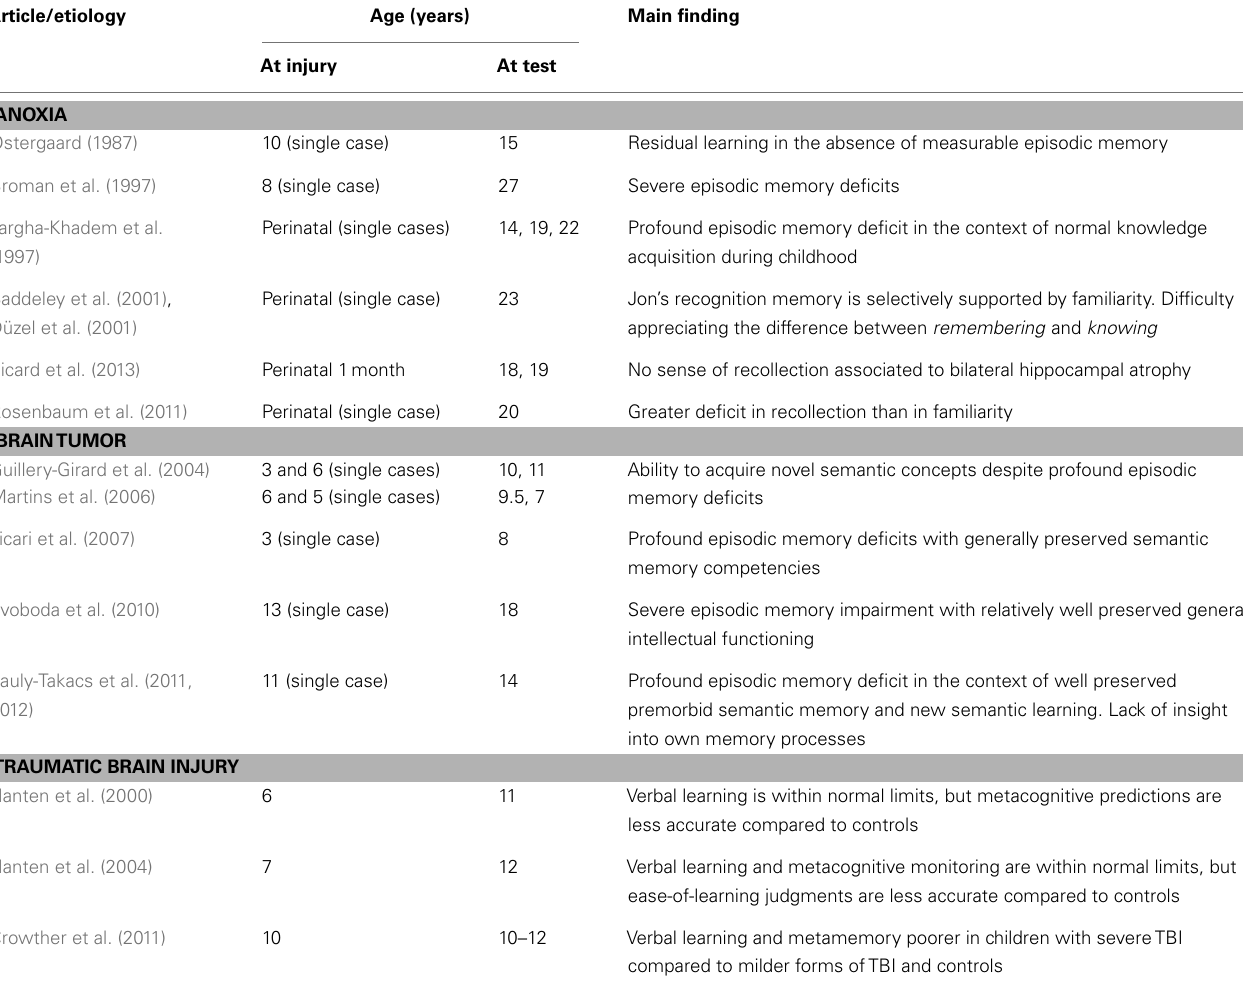
Table 1 | Key findings on episodic memory and metamemory in children and adolescents with anoxia, brain tumor, and traumatic brain injury